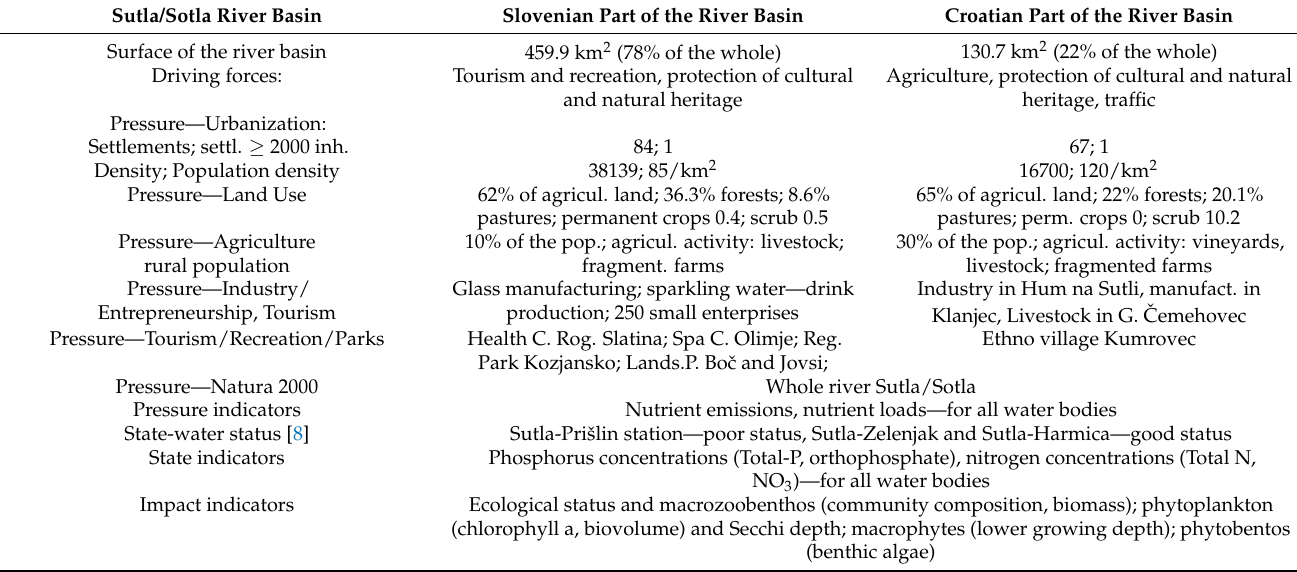
Table 2. DPSIR model input data sources for the Sutla River Basin [10] and added input data sources. Sutla/Sotla River Basin Slovenian Part of the River Basin Croatian Part of the River Basin Surface of the river basin 459.9 km 2 (78% of the whole) 130.7 km 2 (22% of the